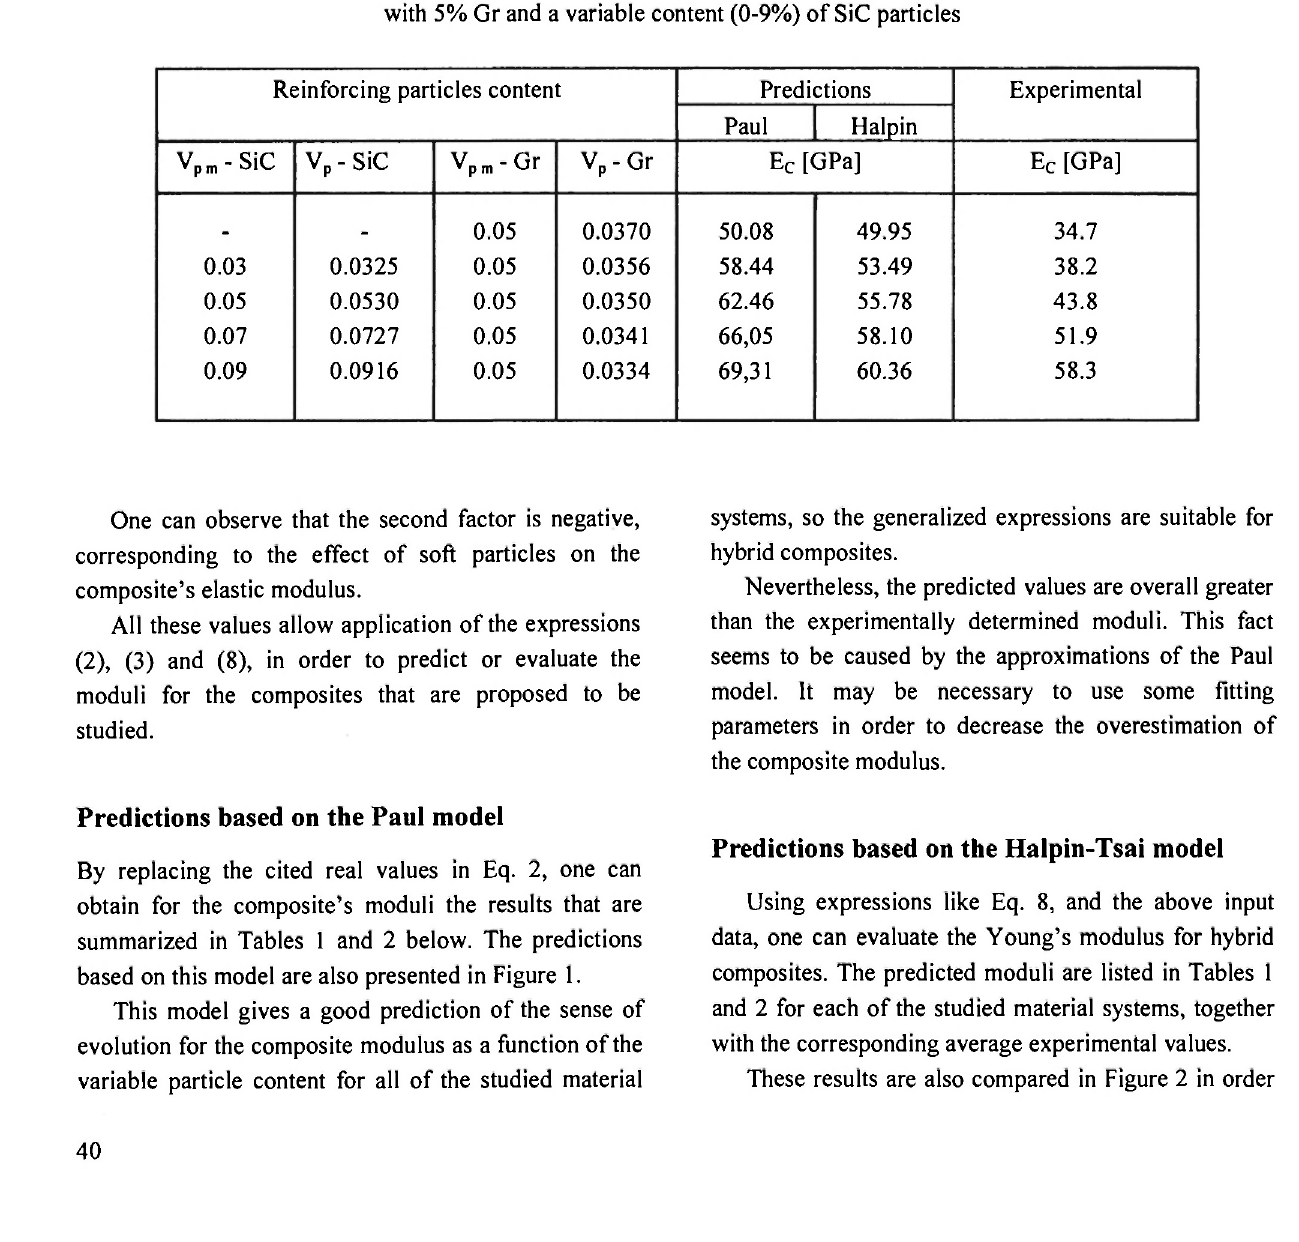
The Paul and the Halpin-Tsai predictions versus the experimental values of Young's modulus, for hybrid composites with 5% Gr and a variable content (0-9%) of SiC